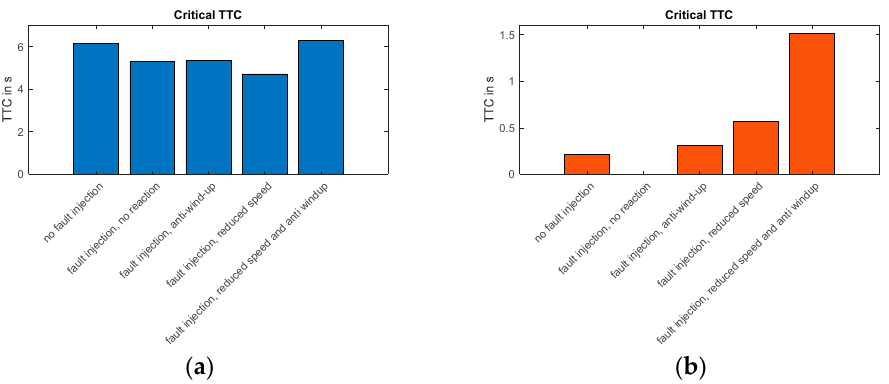
Figure 10. Mean ( a ) and minimal ( b ) values of the minimal TTC values resulting from the parameter variation.